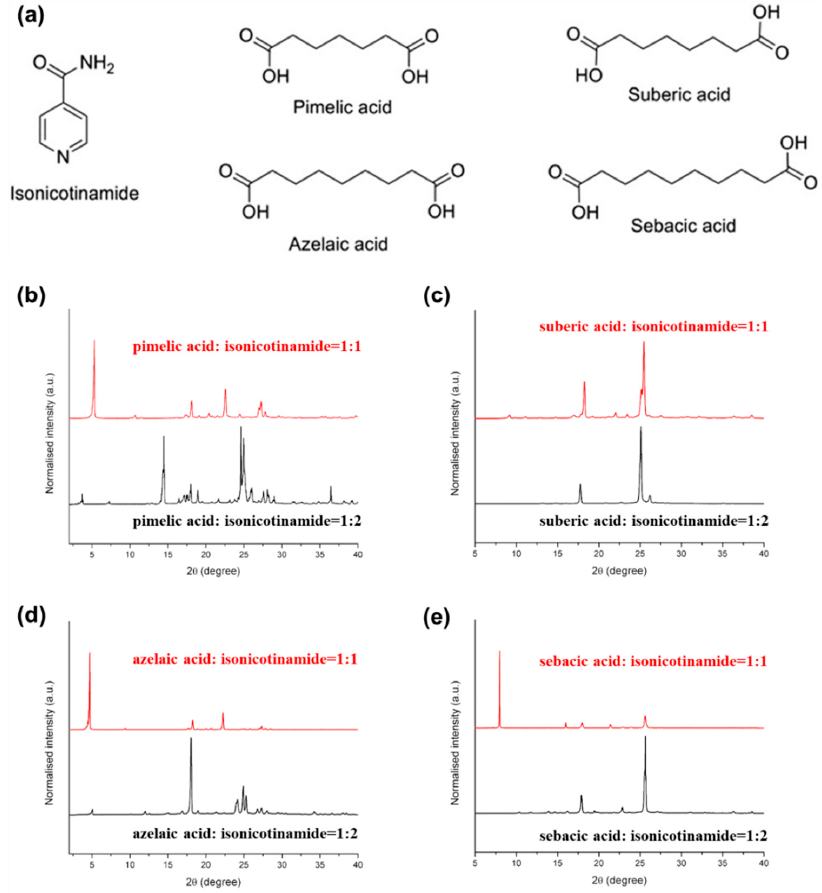
Figure 2. ( a ) Isonicotinamide and coformers (dicarboxylic acids) used for cocrystallization; ( b ) Powder X-ray diffraction (PXRD) of pimelic acid: isonicotinamide (red) (1:1) crystals and (black) (1:2) crystals; ( c ) PXRD of suberic acid: isonicotinamide (red) (1:1) crystals and (black) (1:2) crystals; ( d ) PXRD of azelaic acid: isonicotinamide (red) (1:1) crystals and (black) (1:2) crystals; ( e ) PXRD of sebacic acid: isonicotinamide (red) (1:1) crystals and (black) (1:2) crystals. Data are reproduced with permission from [53].